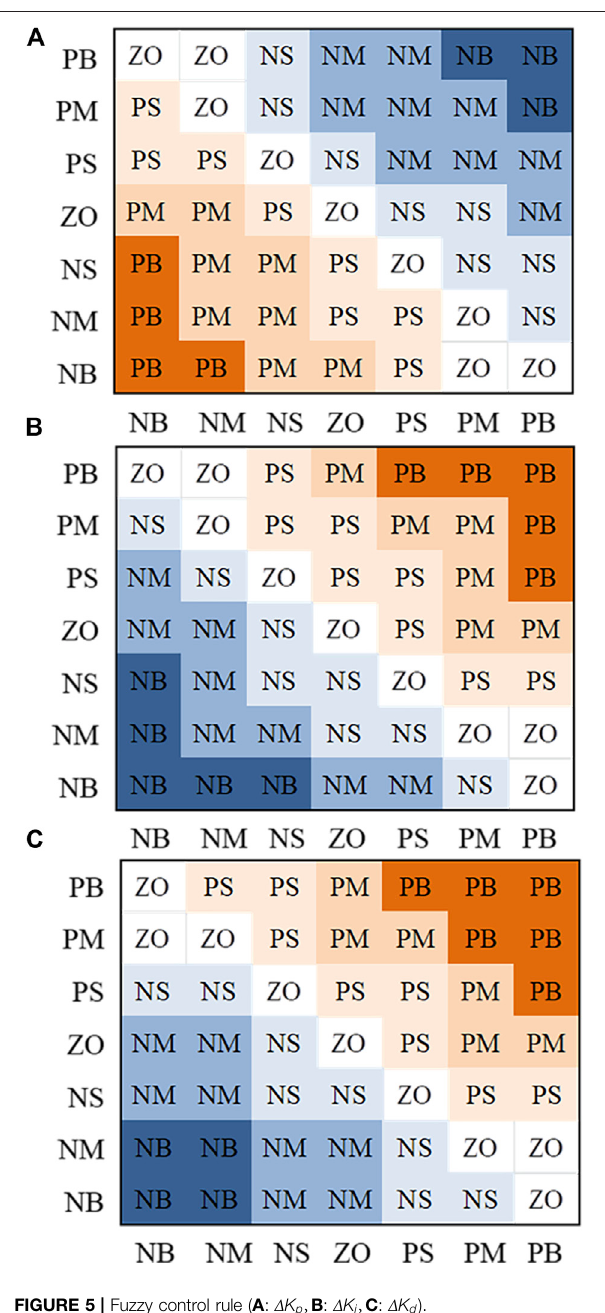
FIGURE 5 | Fuzzy control rule ( A : Δ K p , B : Δ K i , C : Δ K d ).